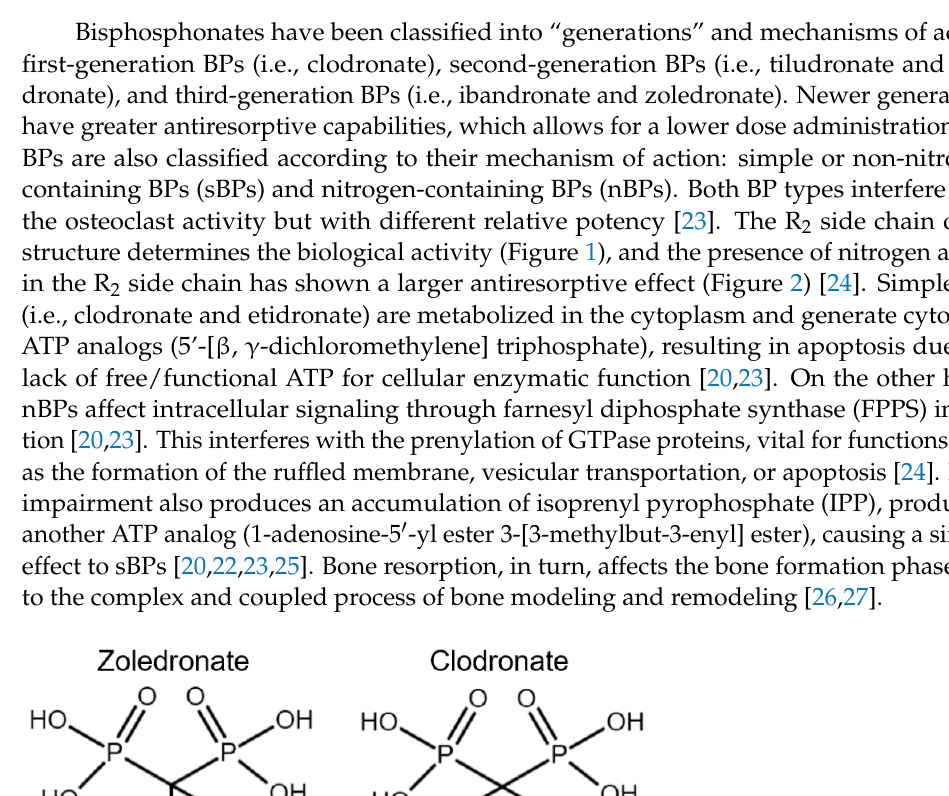
Figure 1. Comparison of pyrophosphate and basic bisphosphonate structures. Bisphosphonates differ from pyrophosphates primarily by the change of oxygen from their central atom to carbon, providing resistance to biological degradation.